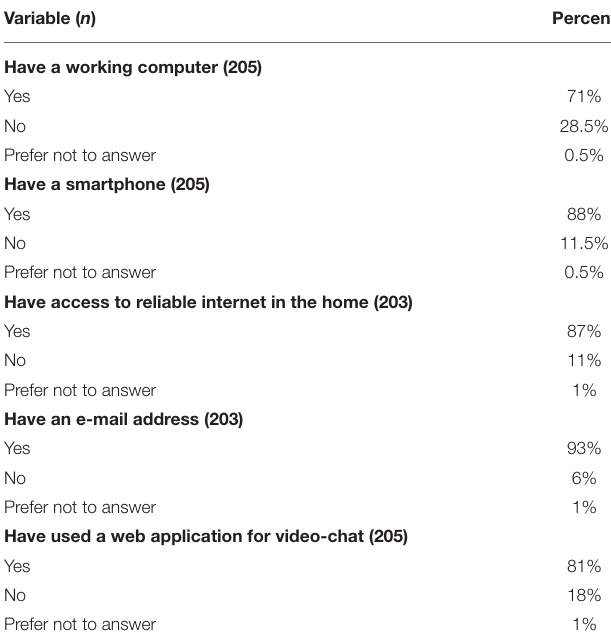
TABLE 4 | Video-chat use survey responses from 205 clients of a low-cost veterinary clinic in Worcester,